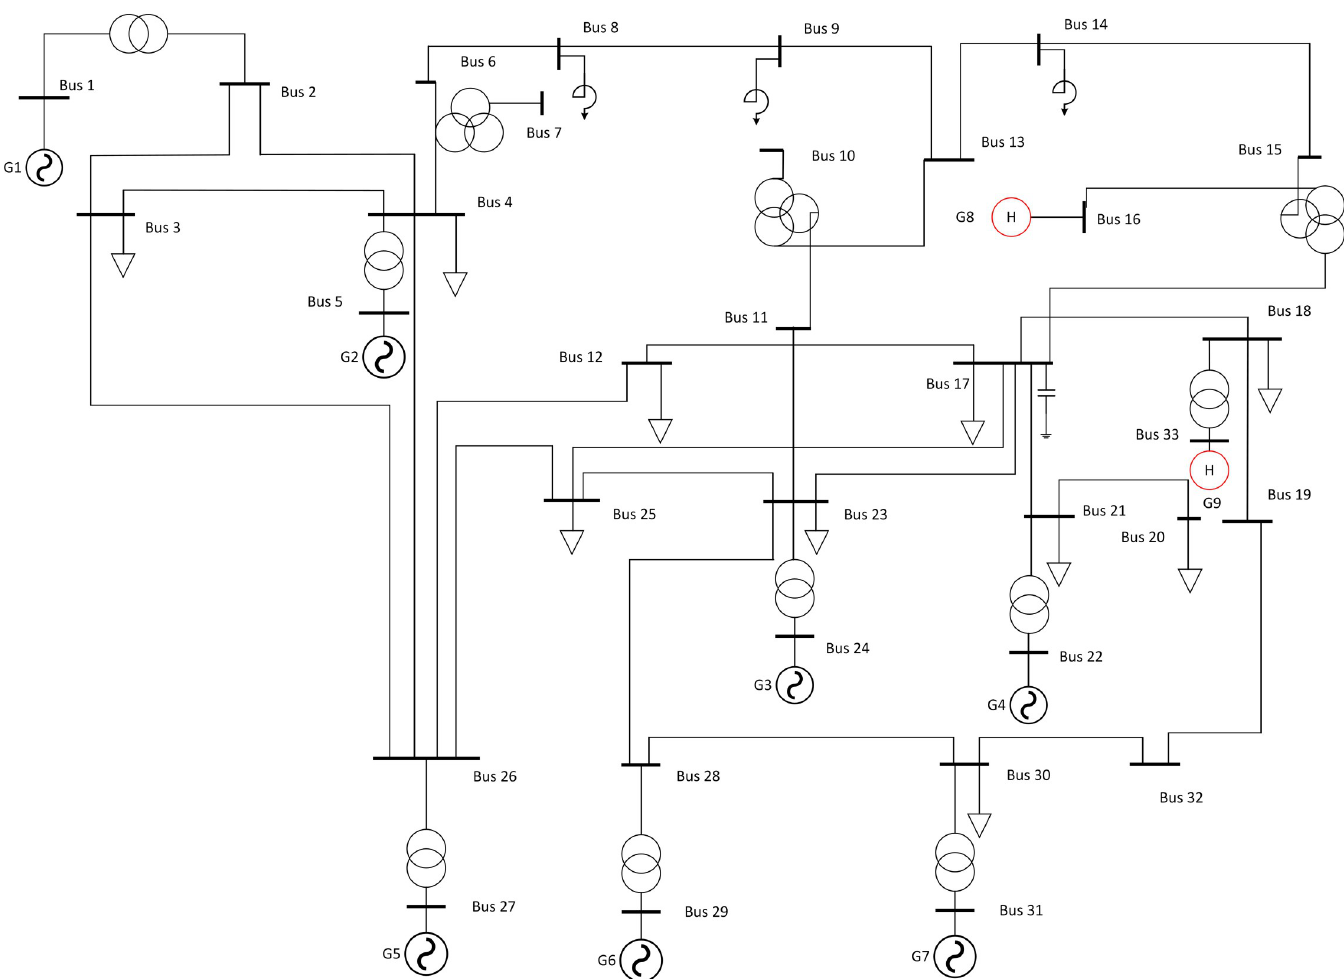
Fig 7. Topology of the EPRI-36 bus system.